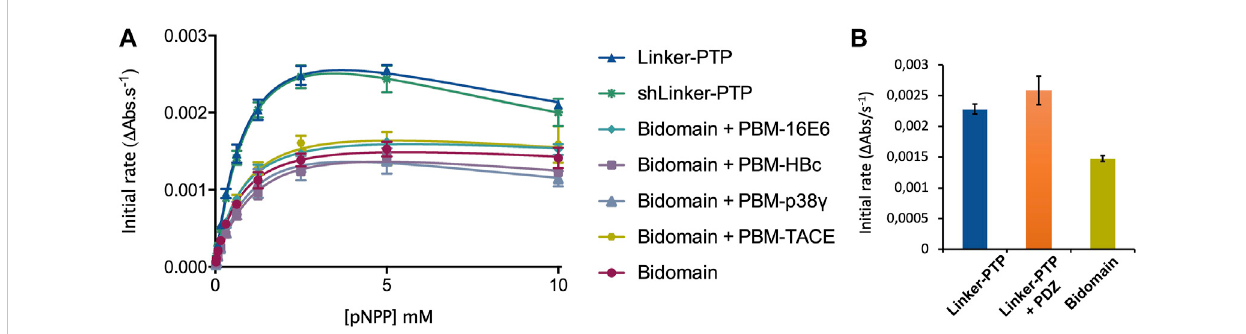
FIGURE 7 Regulation of thephosphatase activity of PTPN3. (A) Michaelis-Menten plots of the initial rates of pNPP hydrolysis by PTPN3 constructs. The K M and k fi tting the data to a modi fi ed Michaelis-Menten equation, considering the substrate inhibition observed at high cat constants were deduced by concentrations of pNPP. The data and error bars are representative of three independent experiments. The curves are nonlinear fi ts to a substrate- inhibition equation. (B) Initial rates of pNPP dephosphorylation at 2.5 mM pNPP by PTPN3-linker-PTP, PTPN3-linker-PTP pre-incubated with PTPN3-PDZ, and PTPN3-Bidomain. PTPN3-linker-PTP and PTPN3-Bidomain were at a concentration of 75 nM, while PTPN3-PDZ was added at a concentration of 6 µM. The data and error bars are representative of three independent